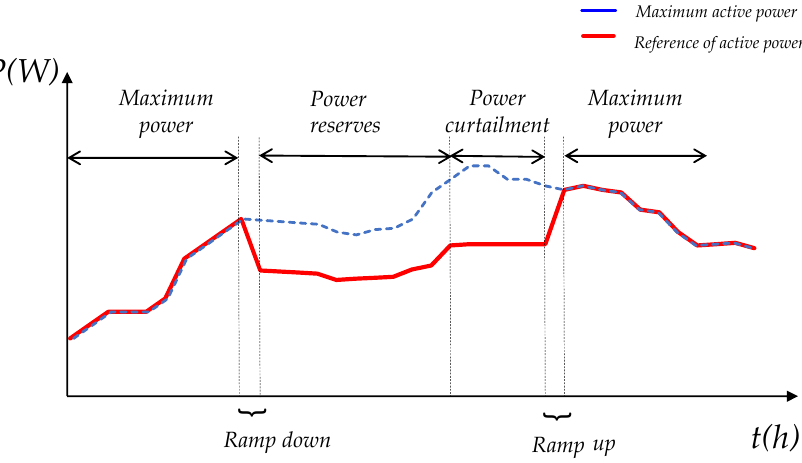
Figure 1. Active power variation applying the new control